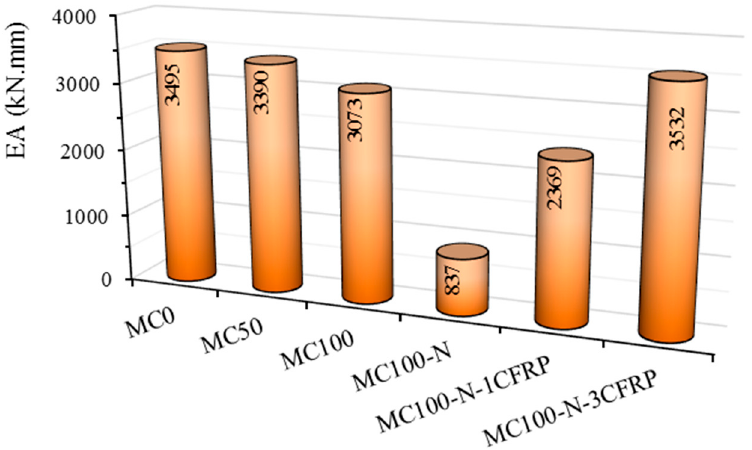
Figure 14. EA Figure 14. EA index.